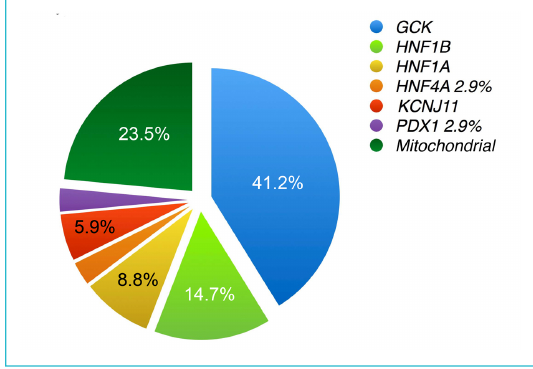
Figure 1: Types and proportions of mutations in surveyed patients with a genetically confirmed diagnosis of monogenic diabetes.The genetic analysis was performed by Sanger sequencing in the 34 patients.